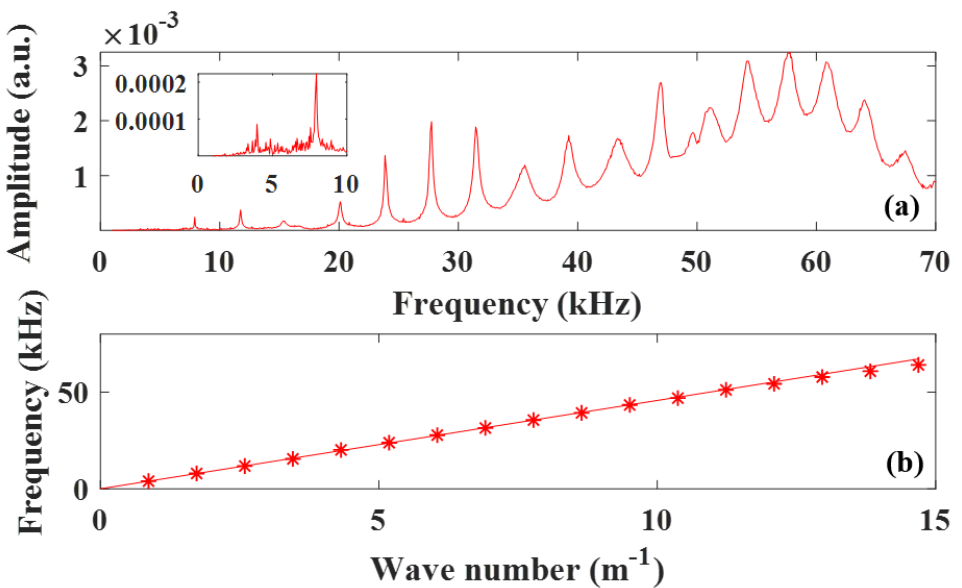
Figure 3. ( a ) Transmission spectrum of the single rod waveguide ( N = 1 ) . The inset in ( a ) identifies the first two resonances at frequency < 10 kHz. The transmission amplitude is in arbitrary units. ( b ) Band structure determined and calculated from ( a ). The asterisks in ( b ) are obtained from the resonances of ( a ) and the solid line associated with the asterisks is a fit to resonances with frequency less than 60 kHz.